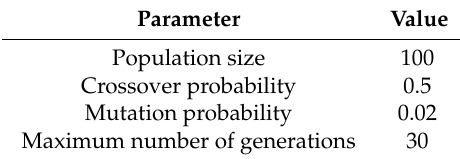
Table 2. Parameters related to the GA-based optimization algorithm.